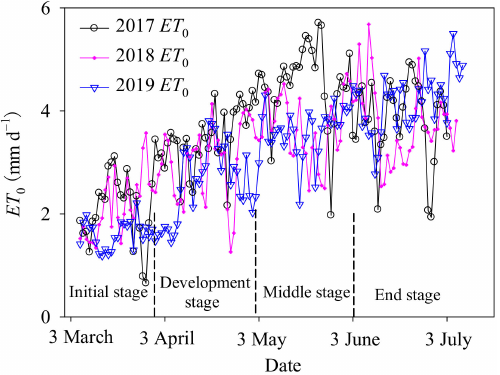
Figure 3. Seasonal variation in reference crop evapotranspiration ( ET 0 ) for greenhouse-grown eggplant during the crop development stages in 3 consecutive years.